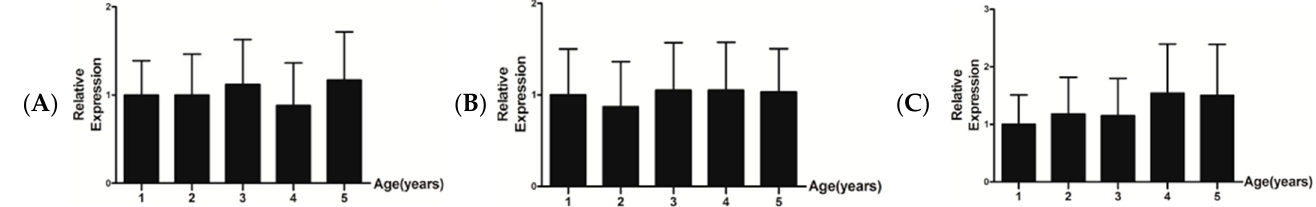
Figure 7. Relative mRNA expression of gene IGF-1 ( A ), FGF5 ( B ), and KAP 1.4 ( C ) in ear skin tissue of the Northwestern Tibetan cashmere goat by age stages (one to five years old). Data are mean ± SD from three independent experiments ( p > 0.05).